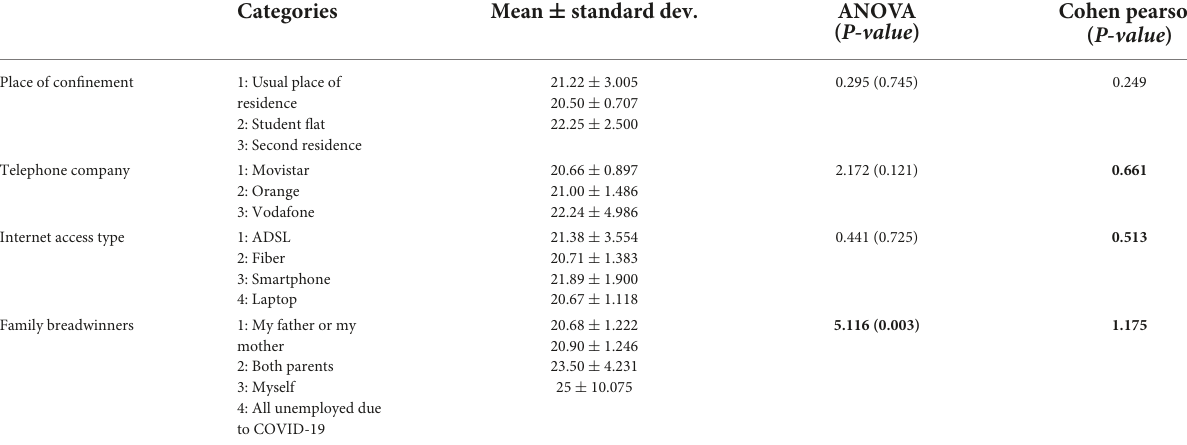
TABLE 4 Measures of association and difference between categories for the study variables and age. Categories Mean ± standard dev. ANOVA